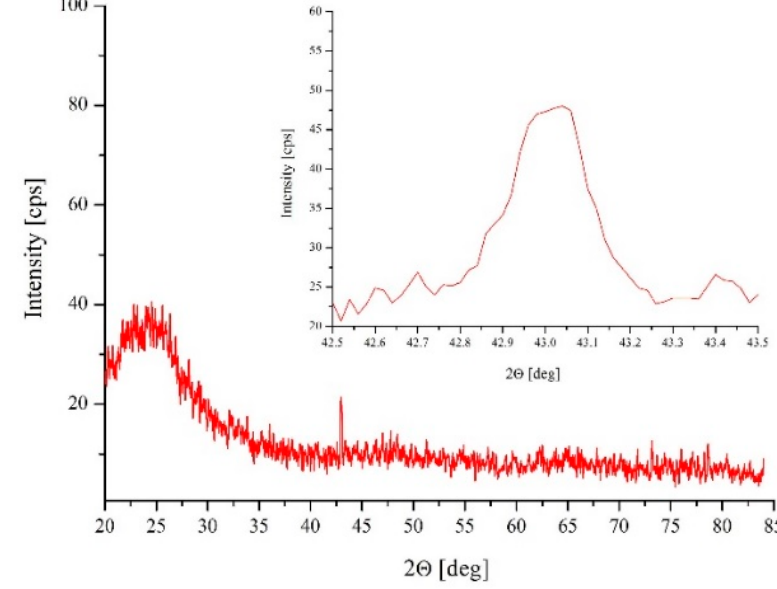
Figure 7. XRD spectra of the as-received sample.